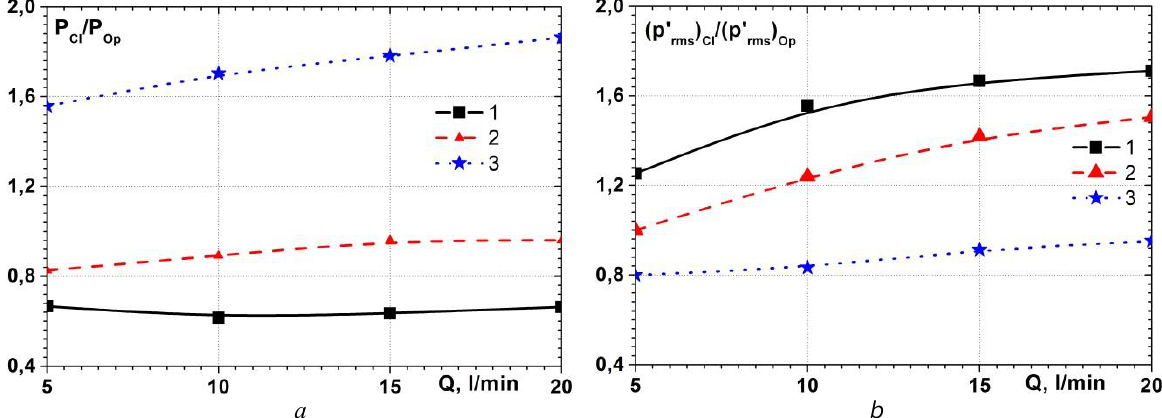
Figure 9. Ratios of the mean pressures (a) and the root-mean-square values of the pressure fluctuations (b) of the hydrodynamic noise inside the left ventricle model of the heart and the atrium model The ratios of the mean pressures and the root-mean-square values of the pressure fluctuations of the hydrodynamic noise near the side and central jets in the near wake of the mitral valve inside the model of the left ventricle of the heart and inside the model of the atrium in front of the mitral valve under the operating conditions of the semi-closed valve to the open valve are shown in Figure 9. Figure 9a shows the ratios of the mean pressure values of the semi- closed valve to the open valve, and Figure 9b shows the ratios of the rms values of the pressure fluctuations. Curve 1 is measured near the lateral jet, curve 2 is measured near the central jet inside the left ventricular model, and curve 3 is measured in front of the valve inside the atrium model. It was found that the mean pressures inside the left ventricular model are slightly decreased under the conditions of the semi-closed valve and significantly increased inside the left atrium model with an increase in the flow rate of the pure water (Figure 9a). The rms values of the pressure fluctuations in the common frequency band are increased under the conditions of the semi-closed valve and, with an increase in the pure water flow rate, the ratios become larger, especially near the side jet (Figure 9b).